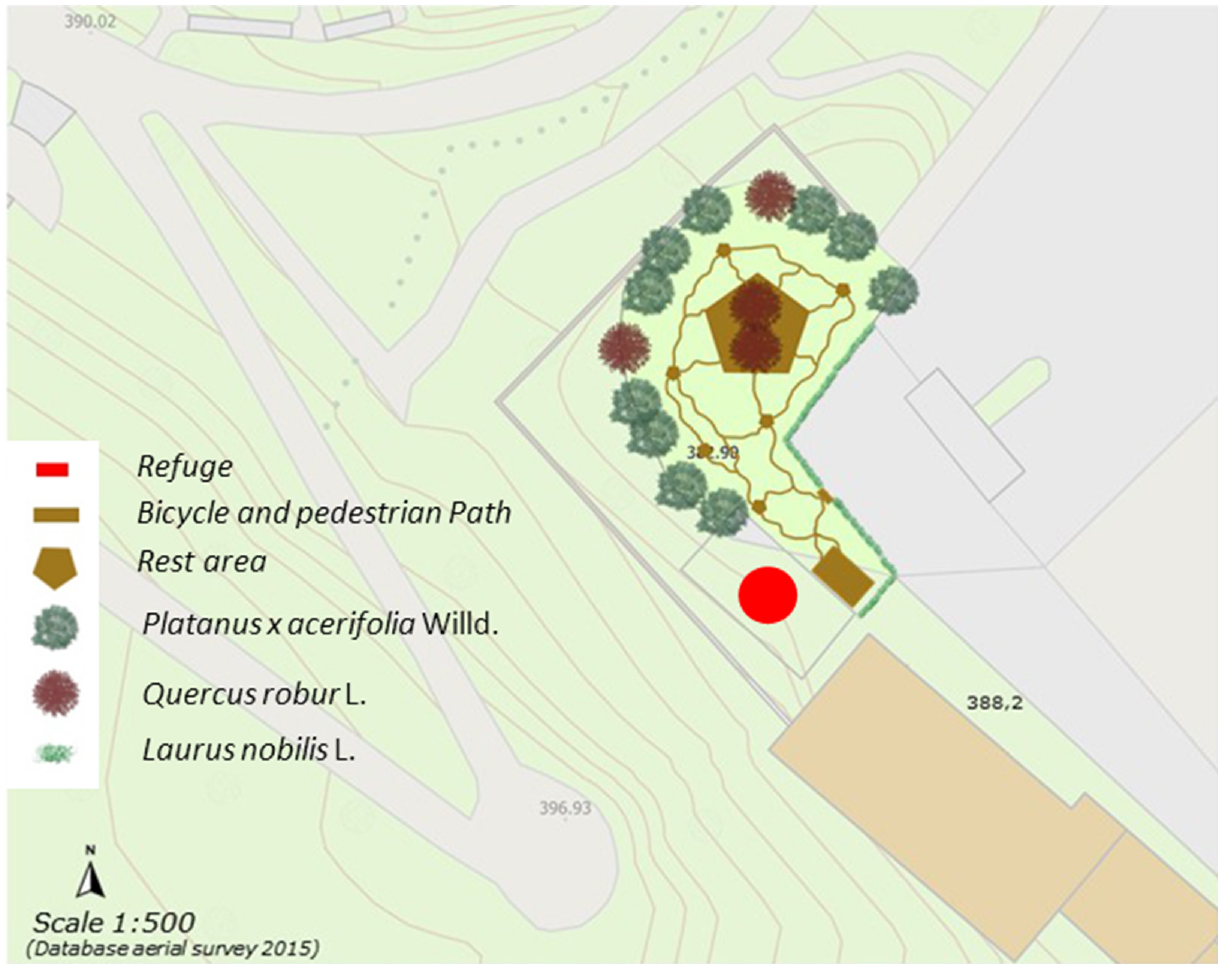
Figure 8. Representation of the area with the introduction of a garden with trees, plants, resting areas, and paths to reach the entrance to the Deep Farm. Elaboration by A. Pilo.